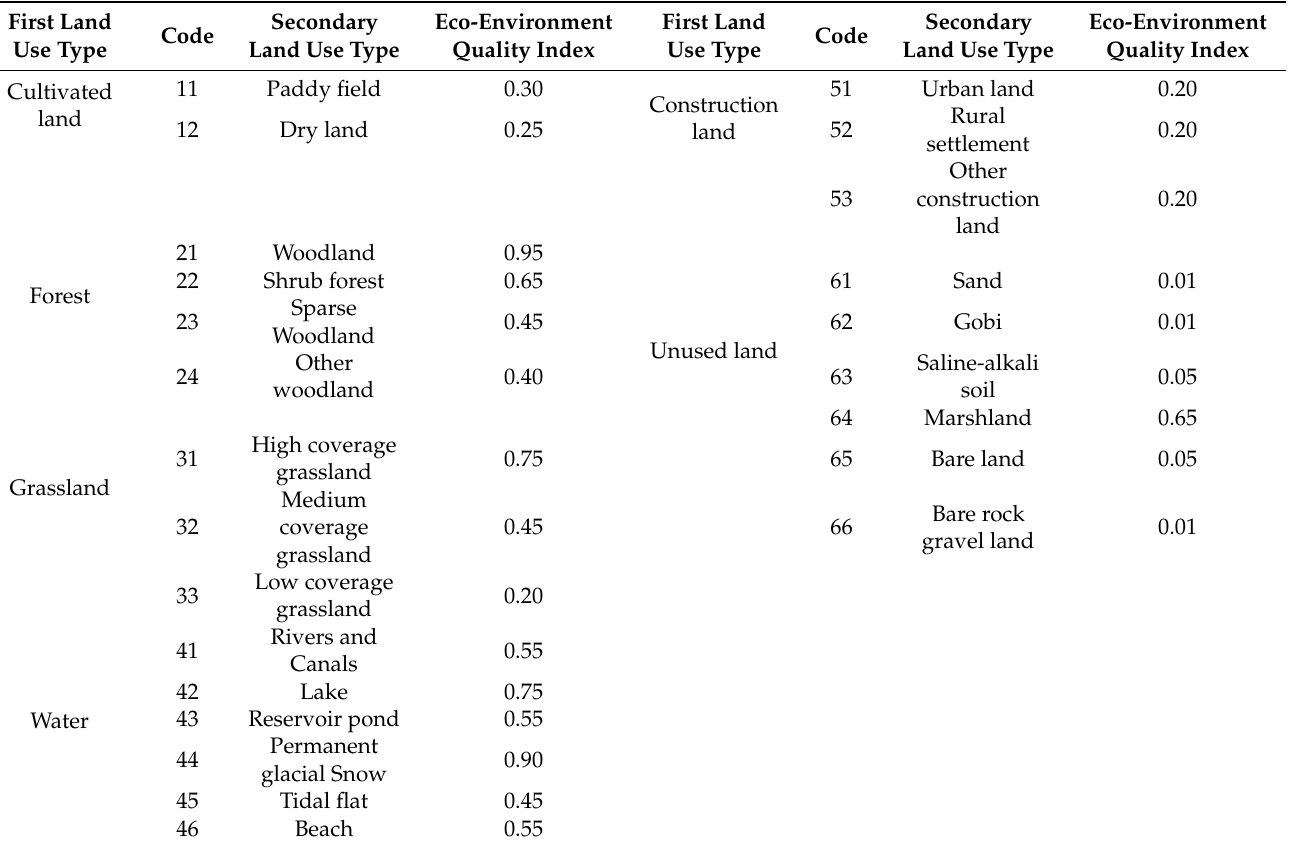
Table 4. Land use classification system and its ecological environmental